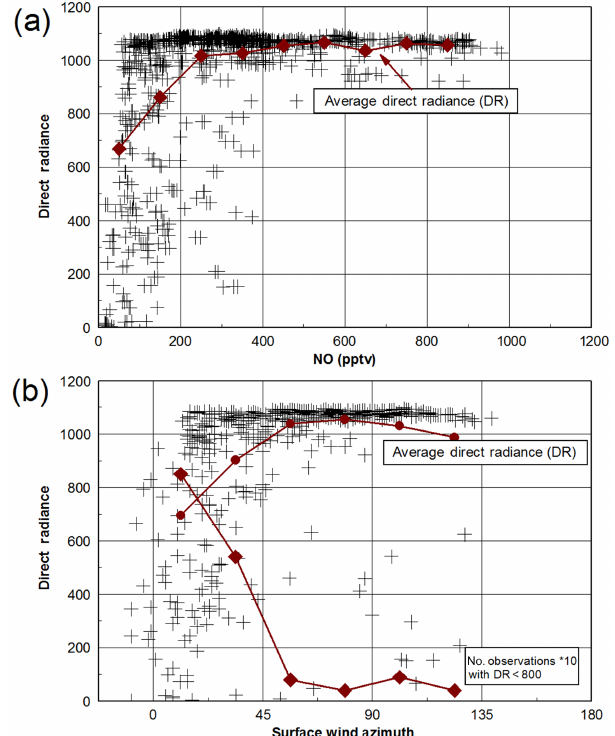
Figure 10. (a) Direct radiance (DR) vs. NO (hourly) for 2003 show- ing that values of NO > 400pptv occur with virtually clear skies (DR > 80% of the maximum). (b) Direct radiance vs. surface wind direction (hourly) for 2003 with average DR and number of obser- vations in 45degree bins, showing cloudy to partly cloudy condi- tions prevail with surface wind directions less than 45 ◦ .